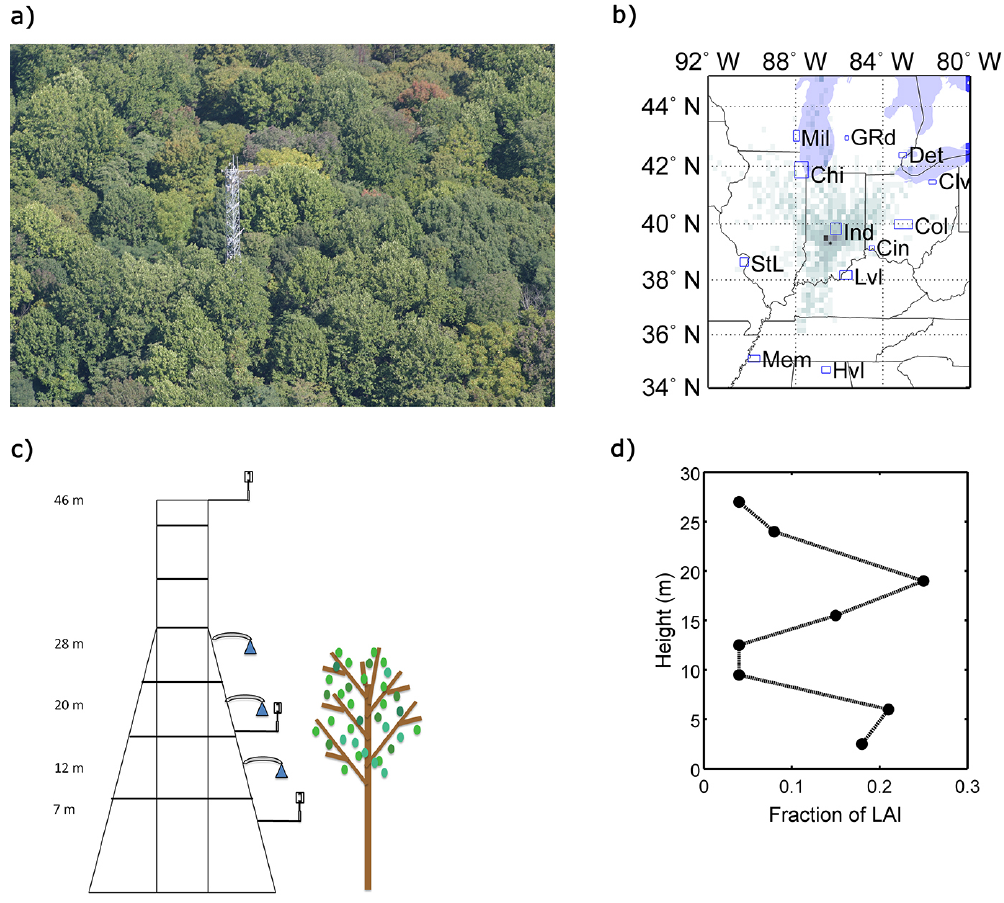
Figure 1. Overview of the measurement location and instrumentation deployed in Morgan Monroe State Forest (MMSF). (a) Photograph of the MMSF tower and surrounding canopy taken in September 2013. (b) Map showing the location of the tower site ( • ). The underlying shading shows the frequency with which 24h back trajectories from MMSF started at the time of min(GMD) passed over a grid cell (resolu- tion; 0.2 × 0.2 ◦ ) and were within a nominal boundary layer of 500m depth (where a more intense color indicates a higher frequency). Major urban areas in the region are shown using the following three letter designations: Mil = Milwaukee; GRd = Grand Rapids; Det = Detroit; Cle = Cleveland; Col = Columbus; Ind = Indianapolis; StL = Saint Louis; Mem = Memphis; Cin = Cincinnati; Lvl = Louisville and Hvl = Huntsville. (c) Schematic of the MMSF tower and the location of inlets used to sample the PSD. (d) Profile of the fraction of the total leaf area index (LAI) as a function of